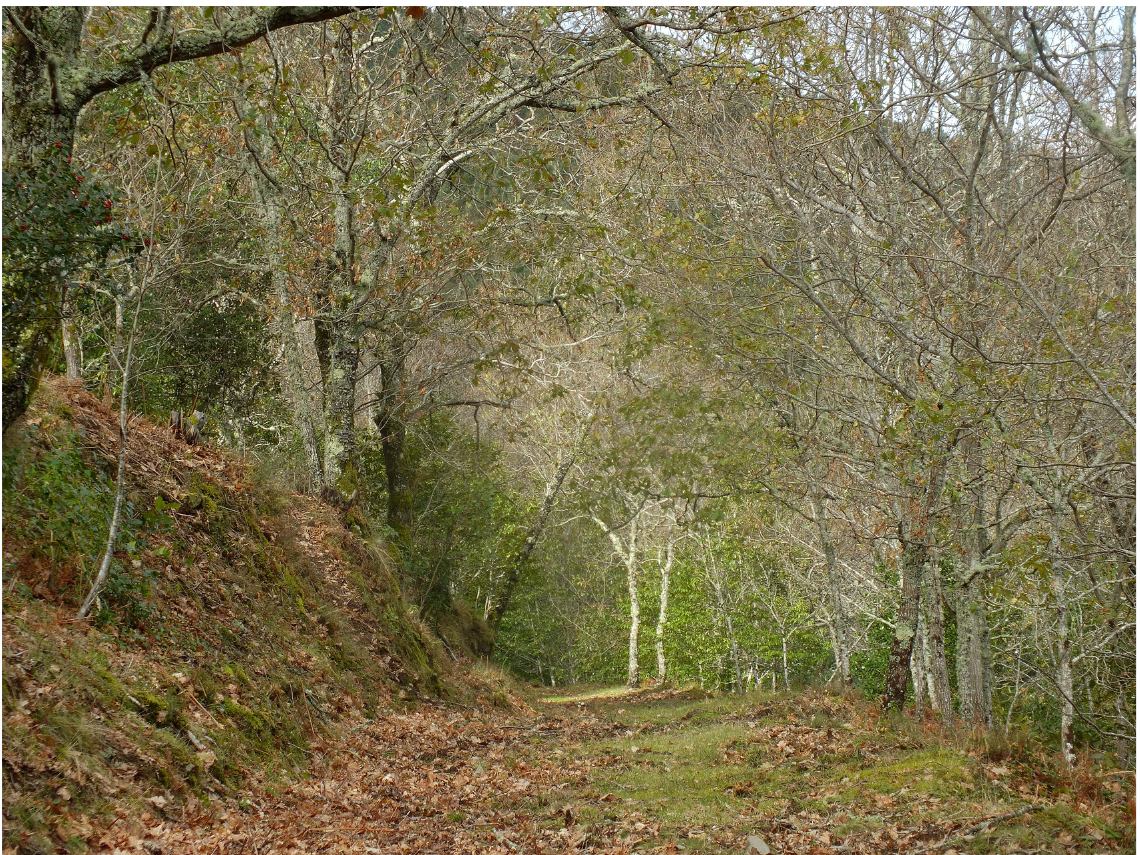
Fig. 25. Habitat of Tachydromia ebejeri Gonçalves, Grootaert & Andrade sp. nov. in a forest of Quercus pyrenaica Willd. in Portugal, Arganil, Benfeita (Mata da Margaraça), a region under submediterranean